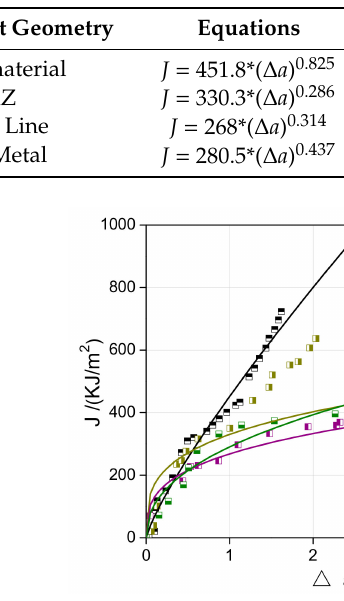
Figure 14. The ensemble of the J- ∆ a resistance curves of the undermatched welded joint.